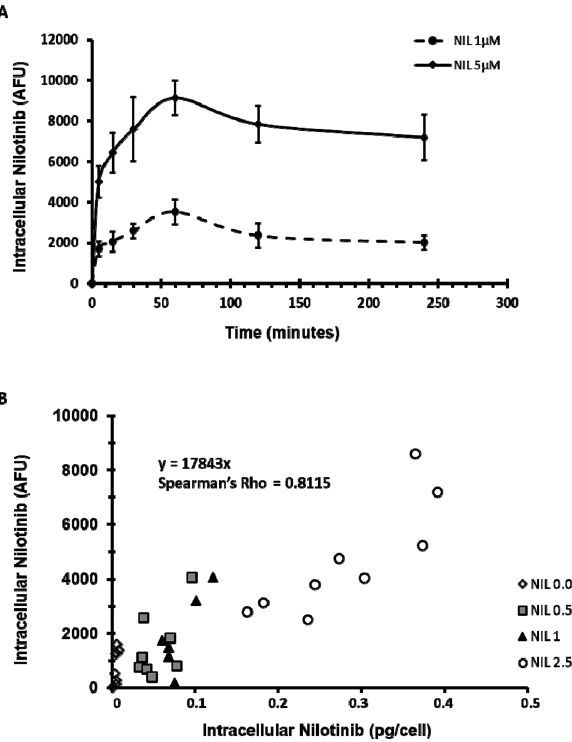
Figure 1. Evaluation of nilotinib uptake in K562 cells by flow cytometry. ( A ) Nilotinib uptake kinetics was evaluated in K562 cells incubated with 1 or 5 µM nilotinib at 5, 15, 30, 60, 120 and 240 min after TKI addition. The analysis showed a rapid nilotinib uptake followed by a plateau. Nilotinib intracellular concentration was defined as the additional fluorescence units relative to the fluorescence of control (untreated) cells. Data are the mean ± standard deviation of 4 experiments. ( B ) Correlation between the flow cytometry data (fluorescence) and nilotinib quantification by HPLC (pg/cell) after lysis of a known number of cells following incubation with nilotinib at the indicated concentrations. This confirmed that in our experimental conditions, the additional fluorescence (expressed as additional fluorescence units) is directly related to the amount of intracellular nilotinib (n = 39). At the lowest nilotinib concentration, nilotinib intracellular amount could be measured only by flow cytometry. NIL, nilotinib; AFU, additional fluorescence